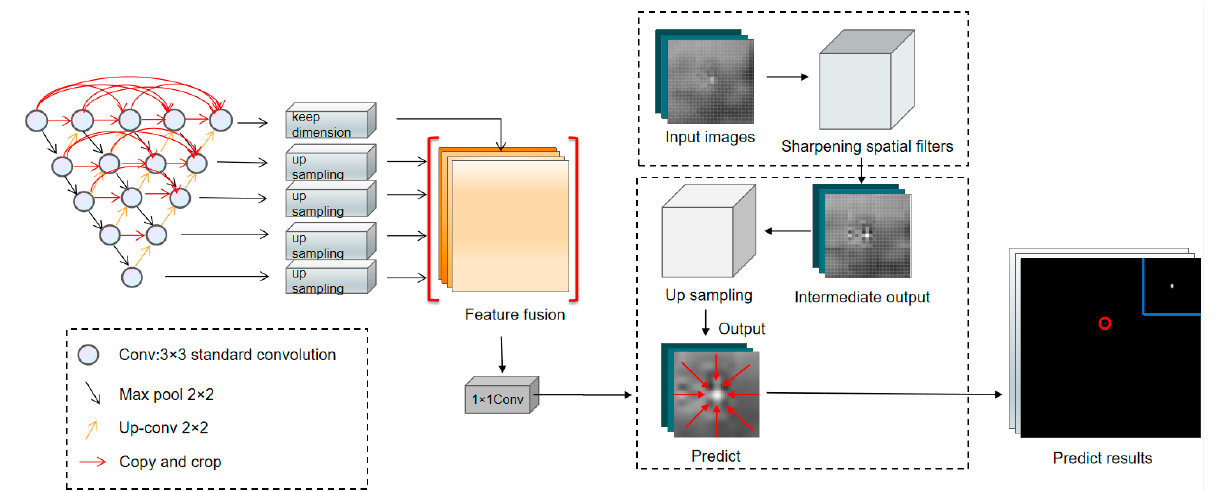
Figure 5. Overall flow chart.